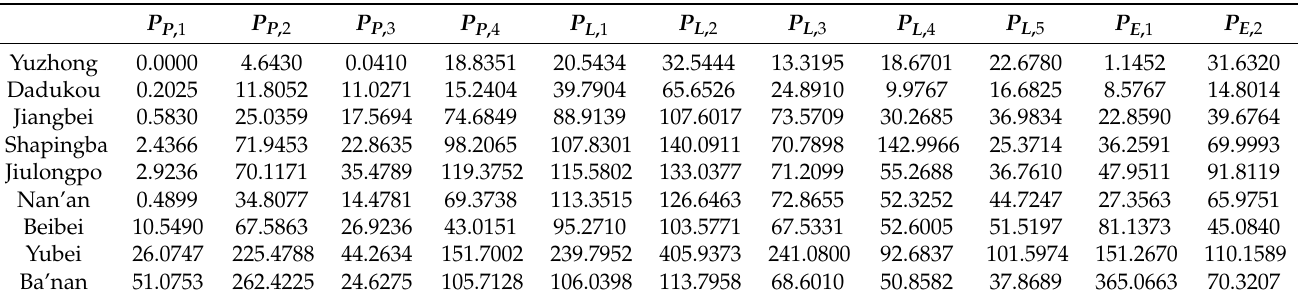
Table 7. The value of P P , i , P L , i , and P E , i in the nine county-level administration districts in 2019 (unit: 10,000 people).